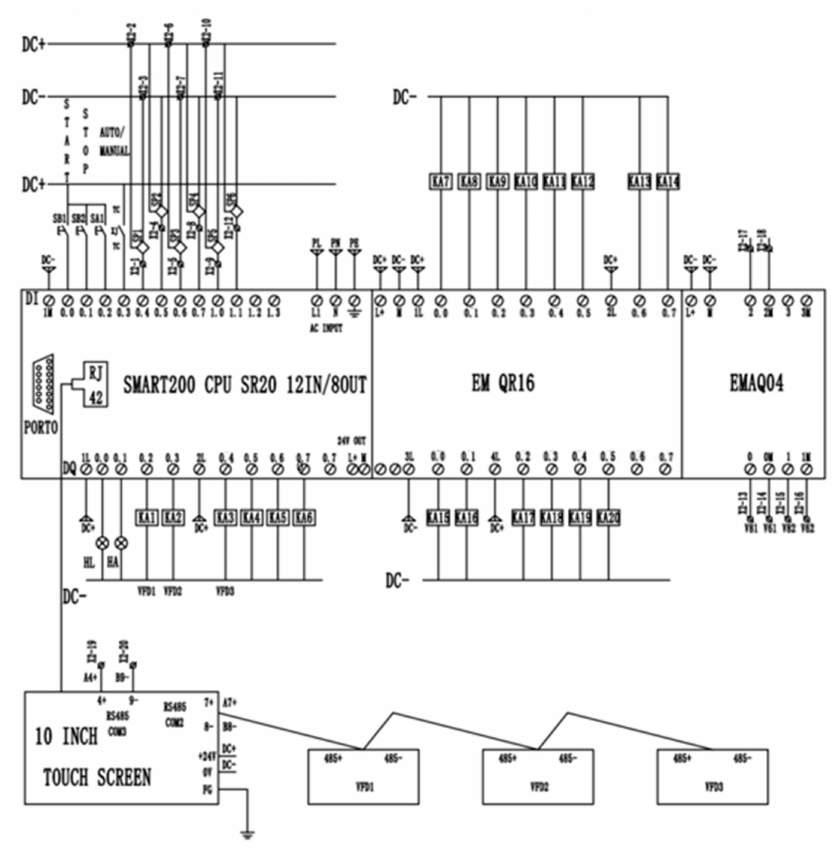
Figure 6. Circuit diagram of double-layer tea winnowing machine control system.